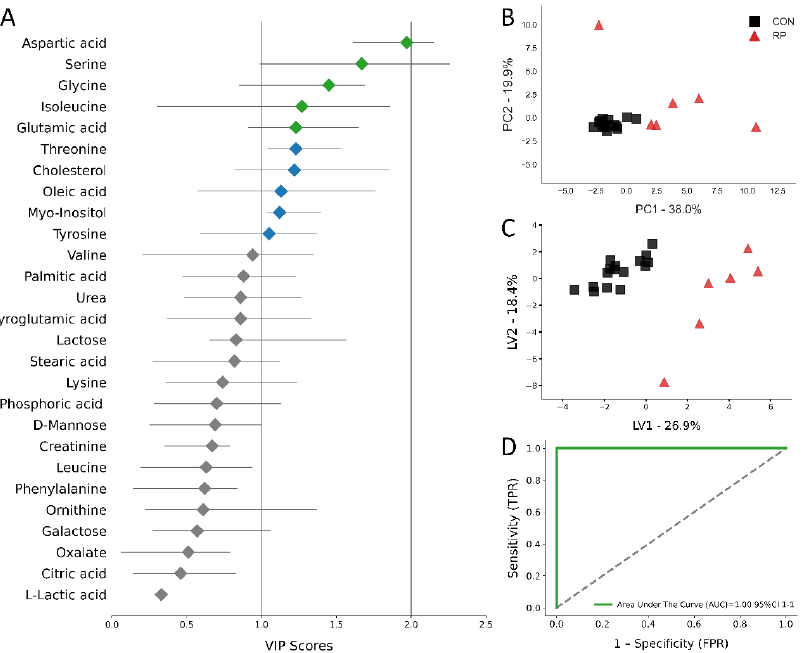
Figure 4. ( A ) Variables ranked by variable importance in projection (VIP), ( B ) PCA, ( C ) PLS-DA (permutation test: p < 0.05) of 16 healthy control (CON) cows and 6 cows pre- RP cows at −8 weeks prior to parturition. ( D ) ROC curve for five top-performing metabolites in Vip Scores.